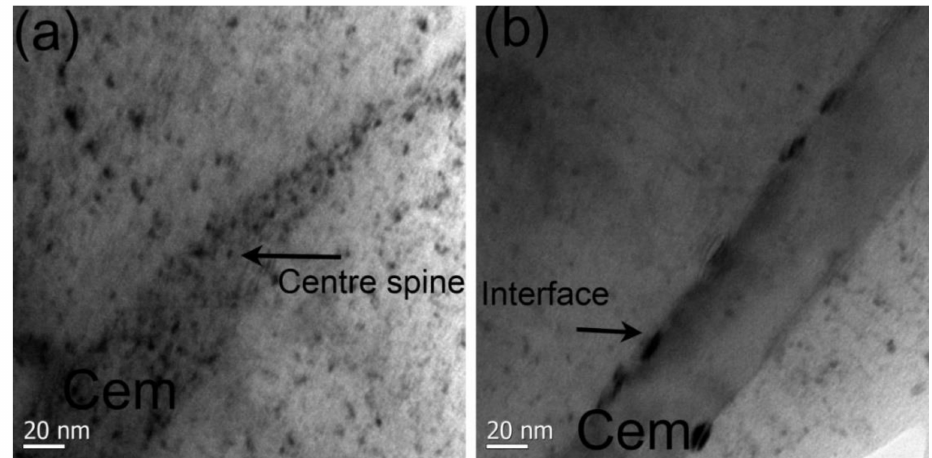
Figure 13. Copper precipitates observed in the cementite of the specimen cooled at 0.5 ◦ C / s. ( a ) Precipitates located in the center spine, ( b ) precipitates located in